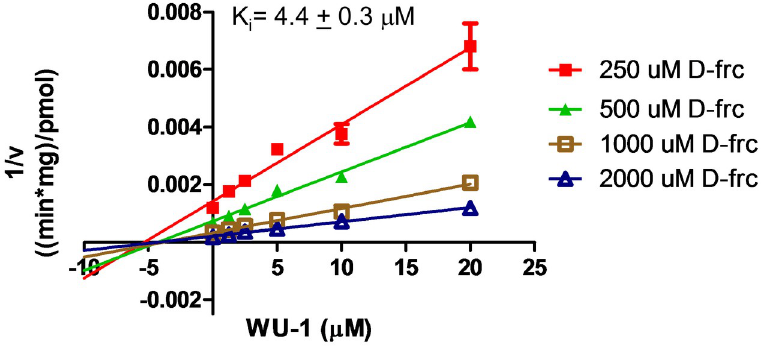
Fig 6. C-1 is a non-competitive inhibitor of PfHT. HEK293PfHT cells were incubated with increasing concentrations of [ 3 H]-D-fructose (Frc). Data were fit by non-linear regression analysis using GraphPad Prism 6.0 software. Uptake data are expressed as means ± SEMs (n = 3). Dixon plot shows WU-1 is a noncompetitive inhibitor with a K i of 4.4 ± 0.3 μ